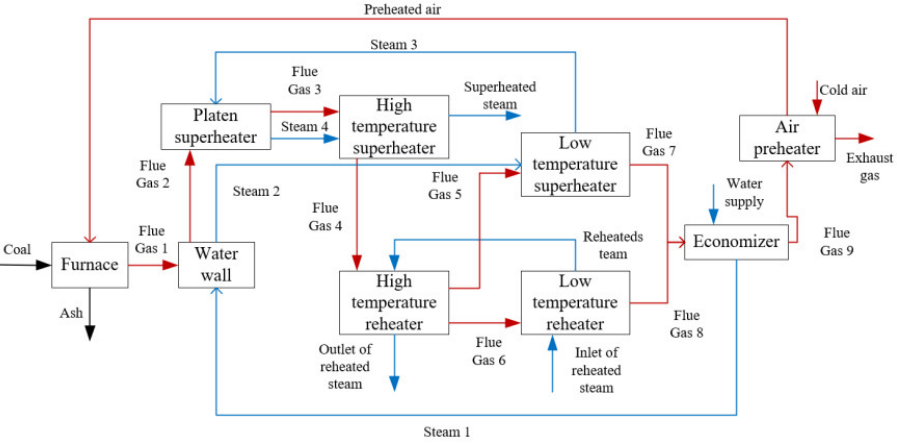
Figure 10. Flow chart of improved system.